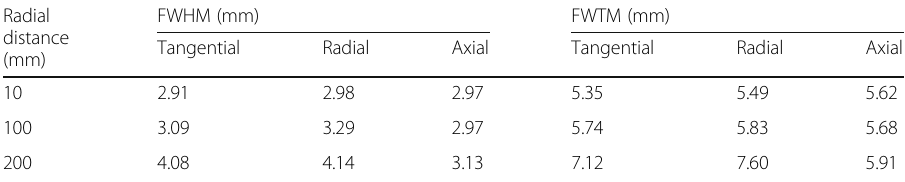
Table 1 The measured NEMA NU-2 2018 spatial resolutions averaged between two transaxial planes Radial